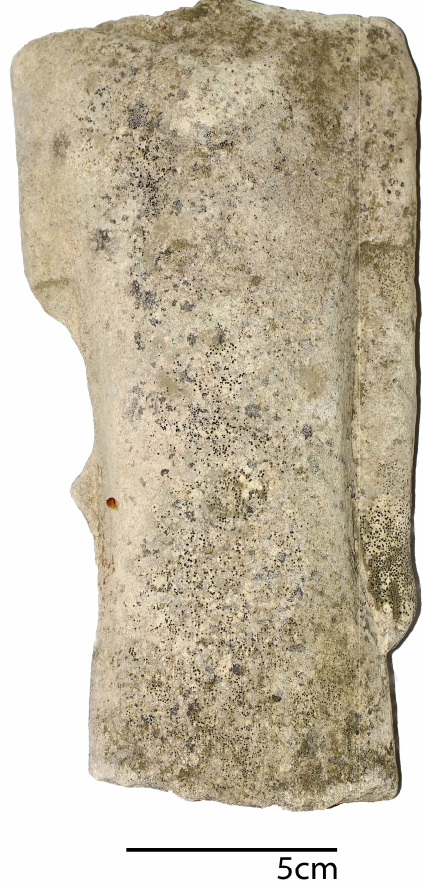
Figure 20. A limestone statuette found in the Xeros River valley (Image by Charalambos